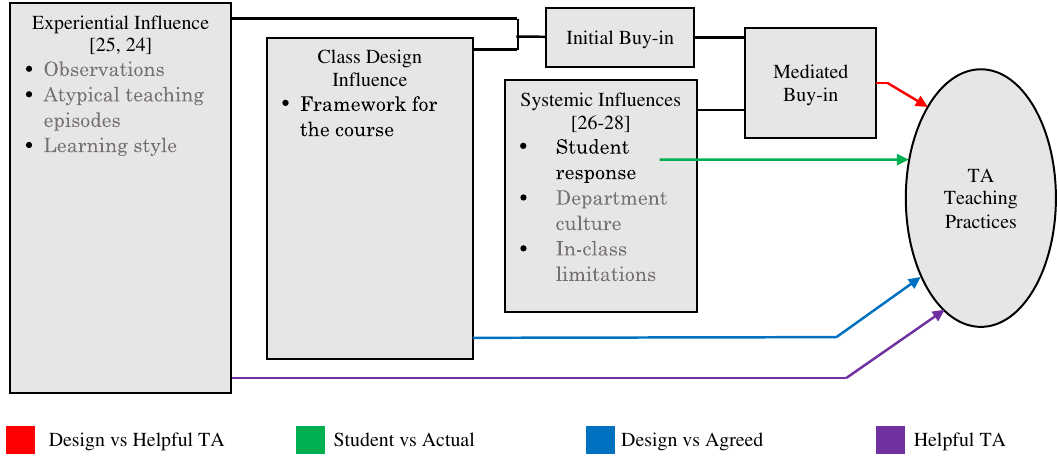
FIG. 6. The theoretical model with the aspects that we have measured. Aspects in gray could be measured given the appropriate prompt. Aspects that could be measured are not limited to those shown here. The legend indicates which prompt or comparison measures the corresponding